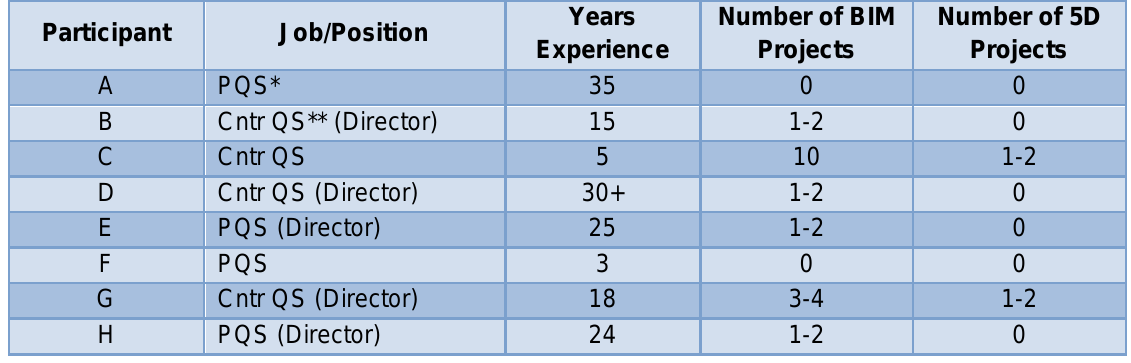
Table 1 Demographic Characteristics of Sample